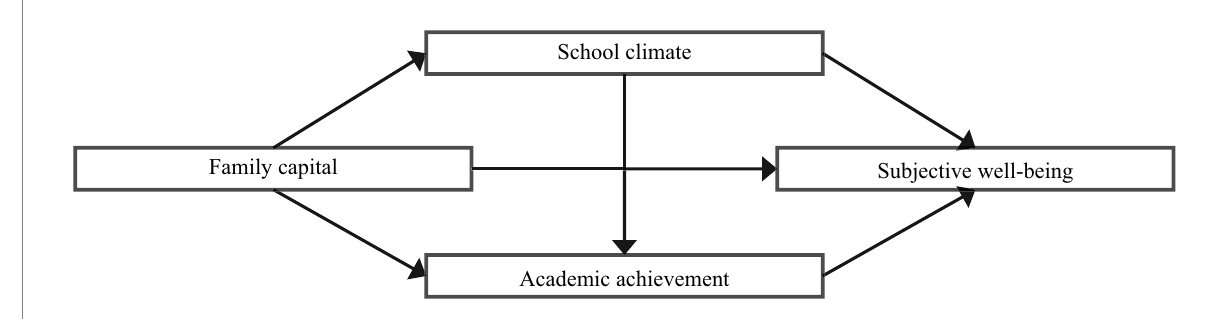
FIGURE 2 Theoretical model of the influence of family capital on adolescents’ subjective well-being.